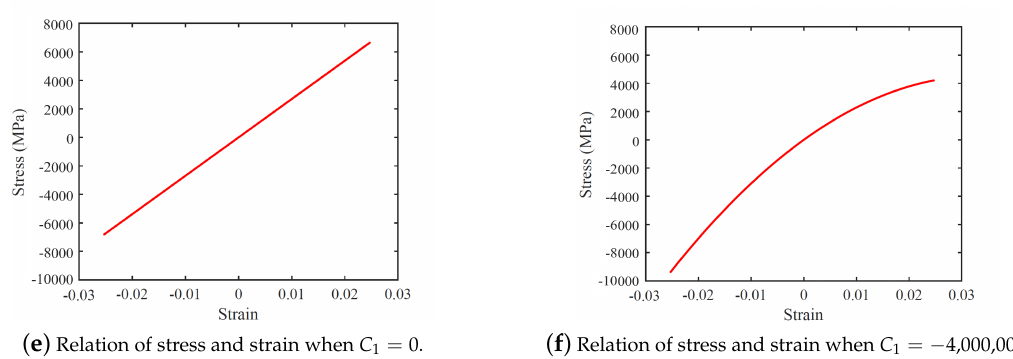
( e ) Relation of stress and strain when C ( f ) Relation of stress and strain when C 1 = 0. 1 = − 4,000,000. Figure 7. Comparative analysis of strain and stress when C 1 is equal to 0 and − 4,000,000 respectively.